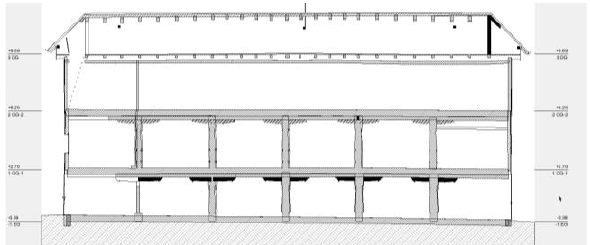
Figure 9 . Longitudinal section of the building with visible